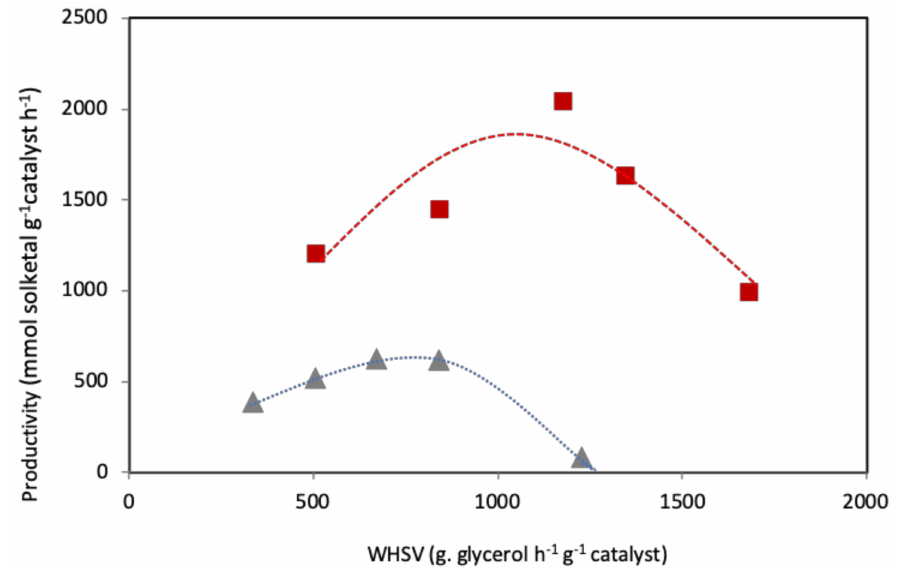
Figure 10. Solketal productivity as a function of WHSV for constant acetone / glycerol ratios of 9:1 ( (cid:4) ) and 4:1 ( (cid:78) ). (Reaction conditions: 45 mg of Glu-195-20 h-S deposited on GF, 25 ◦ C, residence time 1 min).